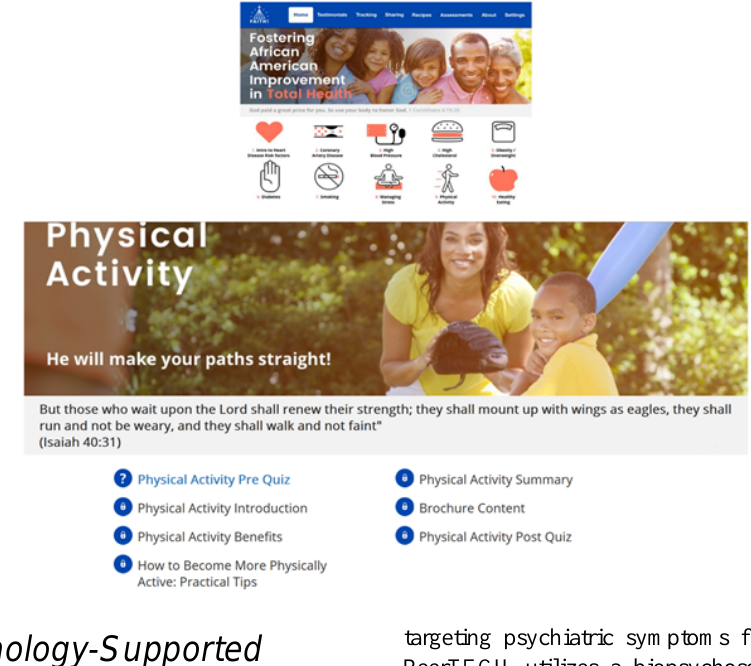
Figure 2. Screenshots of the co-designed FAITH! (Fostering African-American Improvement in Total Health) App home page and education module. Used with permission of the Mayo Foundation for Medical Education and